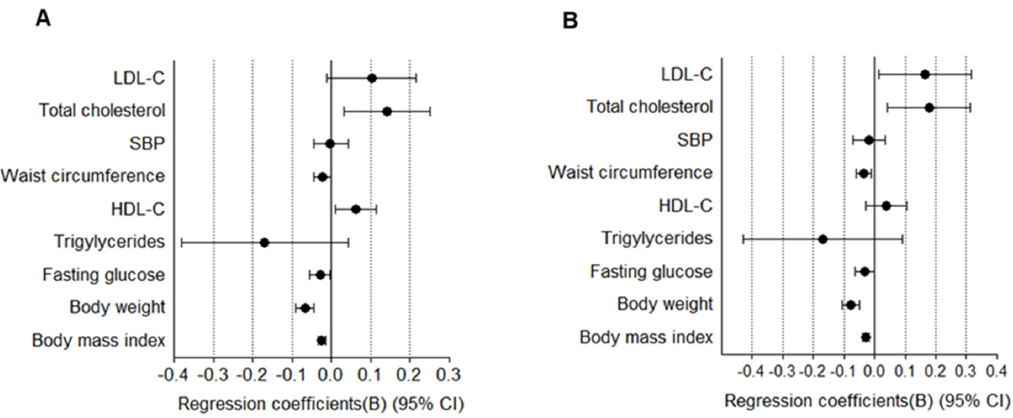
Figure 2. Associations between follicle-stimulating hormone (FSH) and cardiometabolic risk factors in post-menopausal women. ( A ) The model was adjusted for age, estradiol, and body weight. ( B ) The model was adjusted for age, thyroid-stimulating hormone (TSH), and body weight. Data were analyzed using multivariate regression models with each measure as the outcome and follicle-stimulating hormone as the explanatory variable.